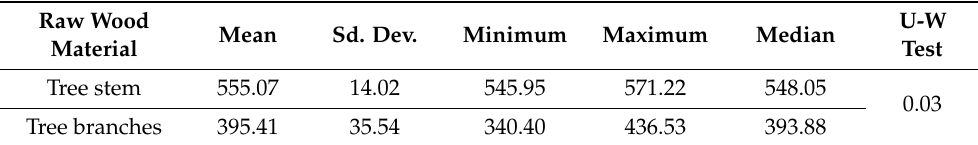
Table 3. Basic statistics of basic density (kg/m 3 ) of raw wood material collected from tree stems and branches